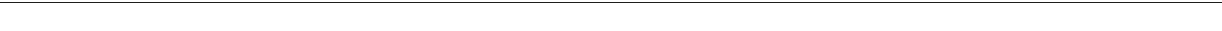
Fig. 2 Bacterial 16S rRNA-based analysis of the fecal microbiota of WT and Gpr43 − / − mice. a Community composition bar plot of the fecal microbiota of naive WT B6 (B6 WT, n = 3) mice and naive Gpr43 − / − mice (GPCR43 − / − , n = 3), WT B6 mice 14 days after allo-BMT (allo-B6 WT, n = 4), Gpr43 − /